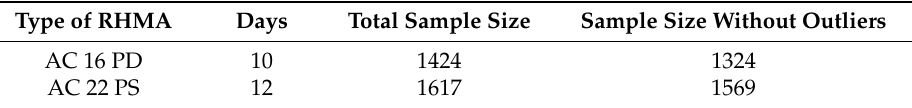
Table 1. Sample sizes of the data used in the investigation Type of RHMA Days Total Sample Size Sample Size Without